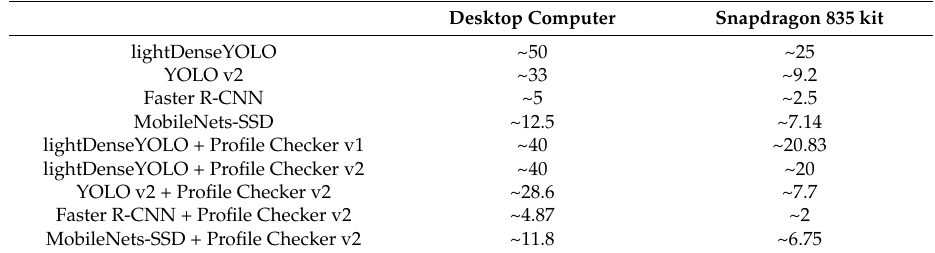
Table 9. Comparisons of average processing speed of proposed method with those of other CNN marker detectors